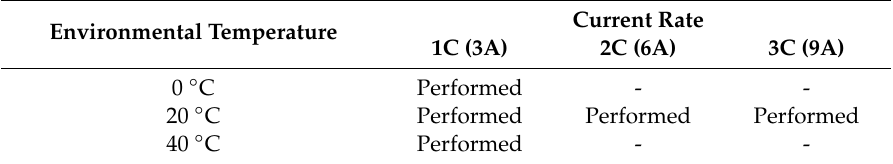
Table 1. The combinations of the experimental condition in order to evaluate the battery module’s charge and discharge